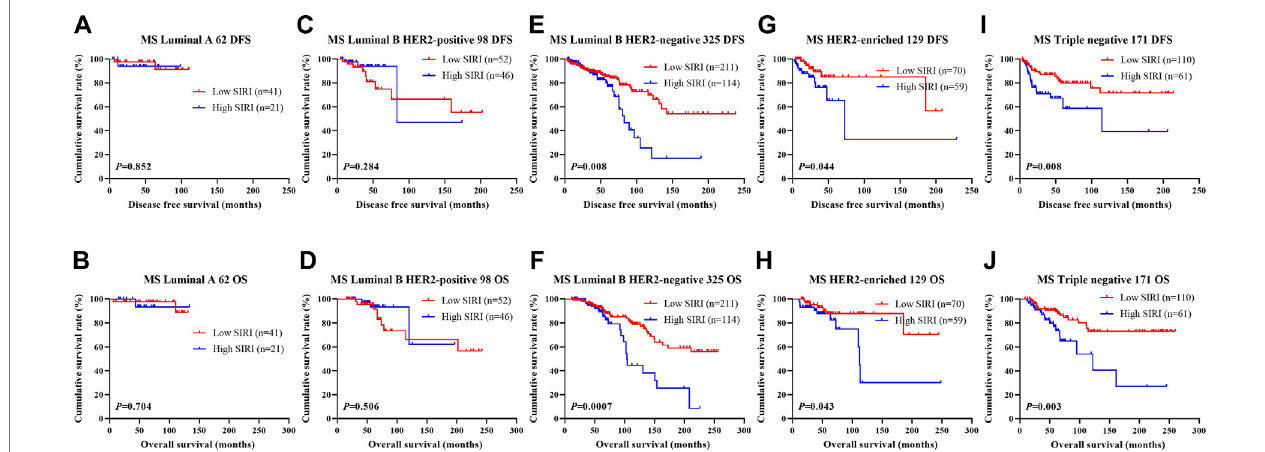
FIGURE 3 | DFS and OS based on SIRI scores in patients with breast cancer of various molecular subtypes. (A) Kaplan-Meier analysis of DFS for the SIRI of patients with luminal A breast cancer. (B) Kaplan-Meier analysis of OS for the SIRI of patients with luminal A breast cancer. (C) Kaplan-Meier analysis of DFS for the SIRI of patients with luminal B HER2-positive breast cancer. (D) Kaplan-Meier analysis of OS for the SIRI of patients with luminal B HER2-positive breast cancer. (E) Kaplan-Meier analysis of DFS for the SIRI of patients with luminal B HER2- negativebreastcancer. (F) Kaplan-MeieranalysisofOSfortheSIRIofpatientswithluminalBHER2-negativebreastcancer. (G) Kaplan-MeieranalysisofDFSfortheSIRI of patients with HER2-enriched breast cancer. (H) Kaplan-Meier analysis of OS for the SIRI of patients with HER2-enriched breast cancer. (I) Kaplan-Meier analysis of DFS for the SIRI of patients with triple-negative breast cancer. (J) Kaplan-Meier analysis of OS for the SIRI of patients with triple-negative breast cancer.